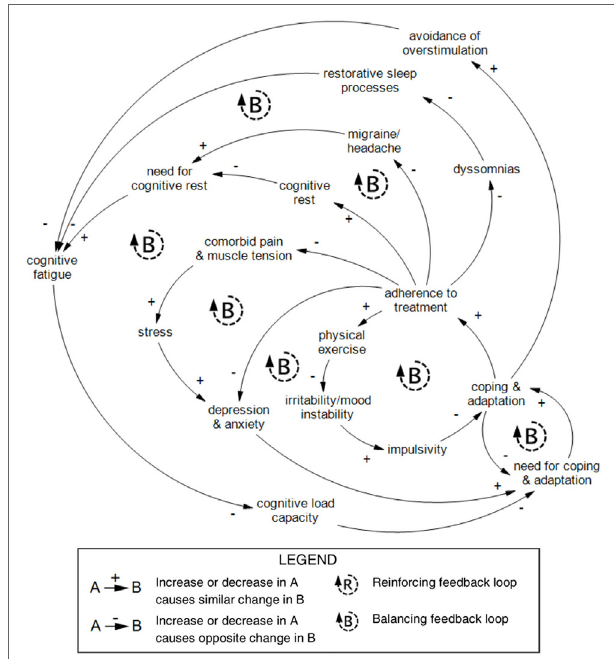
FigUre 7 | Balancing loops related to coping and adaptation within the experiential scale in recovery from concussion. This series of nested balancing feedback loops was reproduced from Figure 1 . A core loop distinguishes coping and adaptation from the need for coping and adaptation. Coping and adaptation lead to two behaviors: avoidance of overstimulation and adherence to treatment. Avoidance of overstimulation reduces cognitive fatigue. Access and quality of medical treatment and advice will vary between cases, but targeted treatments may be prescribed by a clinician to increase cognitive rest or reduce migraine/headache, cognitive fatigue, comorbid pain and muscle tension, stress, depression and anxiety, irritability/mood instability, and impulsivity. Diagram rendered in